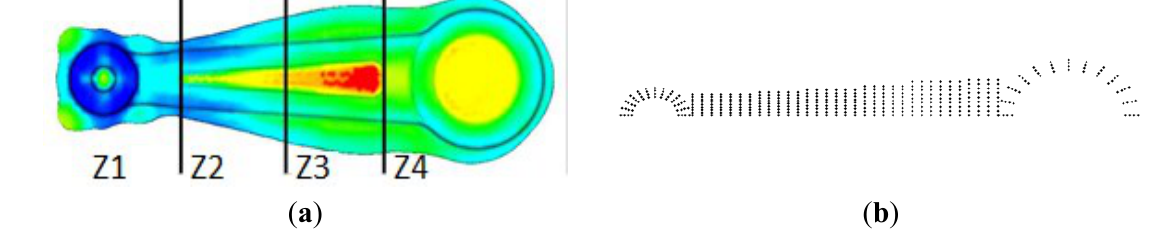
Figure 7. Selection of the locations where microhardness measurements are taken: ( a ) zones to be cut; ( b ) indentation